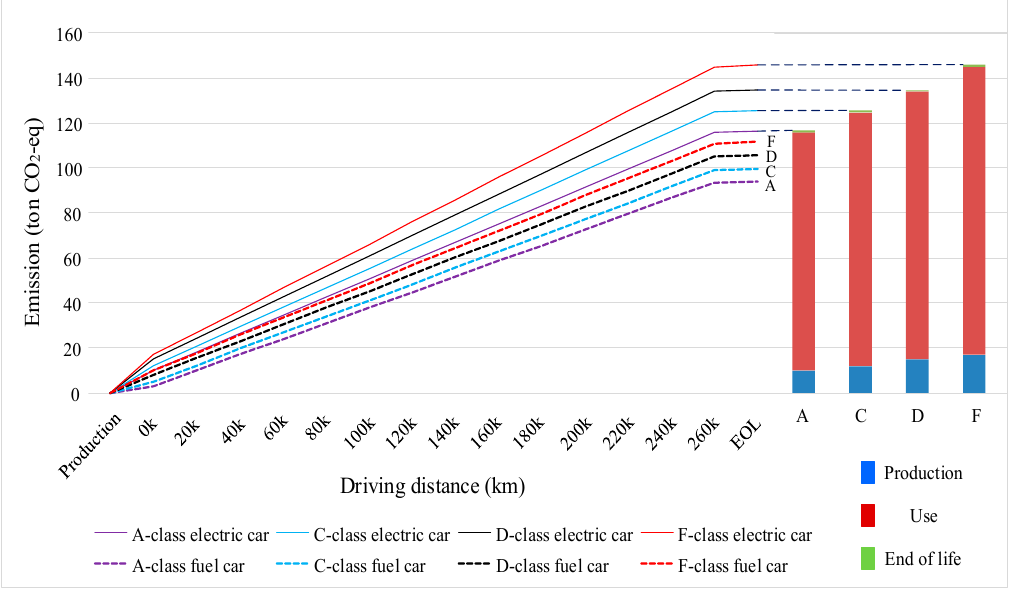
Figure 4. Comparison of life cycle carbon emissions between electric vehicles and fuel vehicles under the current grid mix composition.